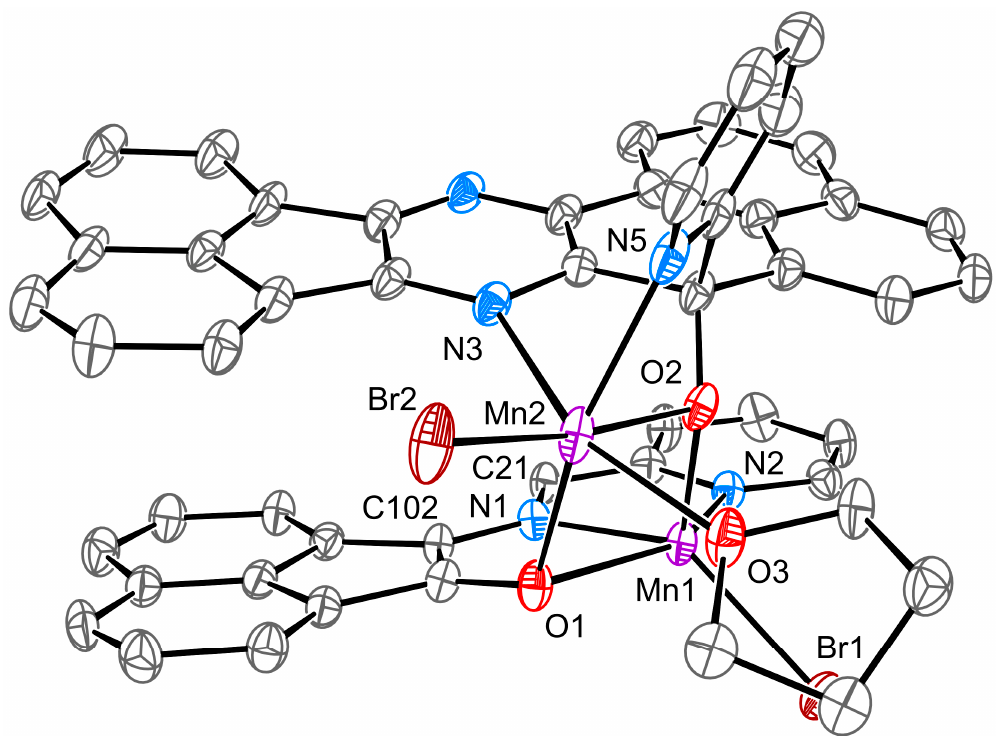
Figure 1. Molecular structure of 1 in the crystal with thermal ellipsoids at the 50% probability level according to single-crystal X-ray diffraction. Hydrogen atoms and solvent molecules are omitted for clarity. Selected interatomic distances [Å]: Br1–Mn1 2.4871(7), Mn1–O1 2.316(3), Mn1–O2 2.031(3), Mn1–N1 2.191(3), Mn1–N2 2.265(3), Br2–Mn2 2.5335(7), Mn2–O1 2.208(3), Mn2–O2 2.139(3), Mn2–